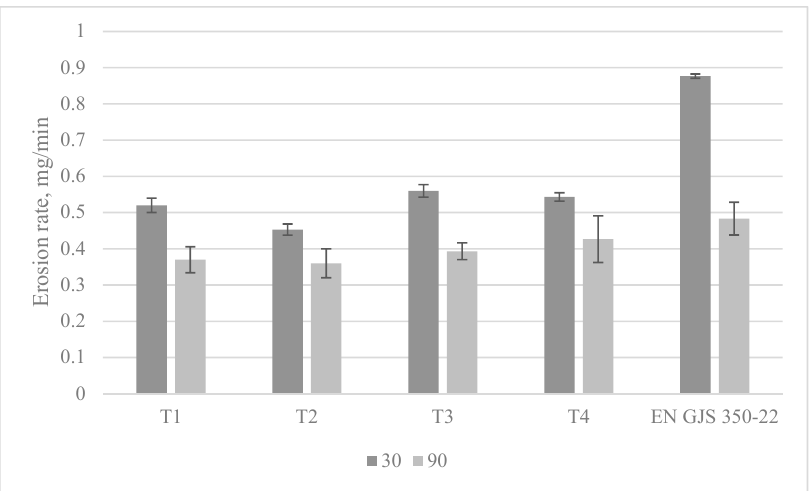
Figure 10. Average erosion rate results of tested laser alloyed surface layers and reference material.